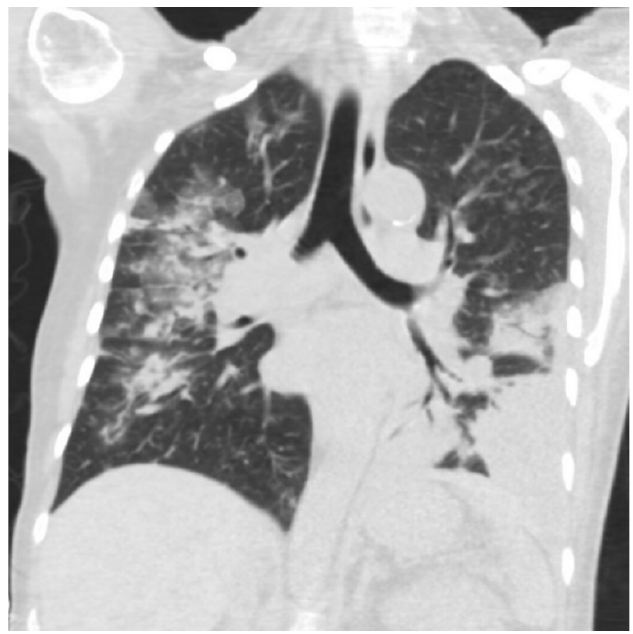
Figure 1. CT of thorax showing left-sided pleural effusion and bilateral airspace